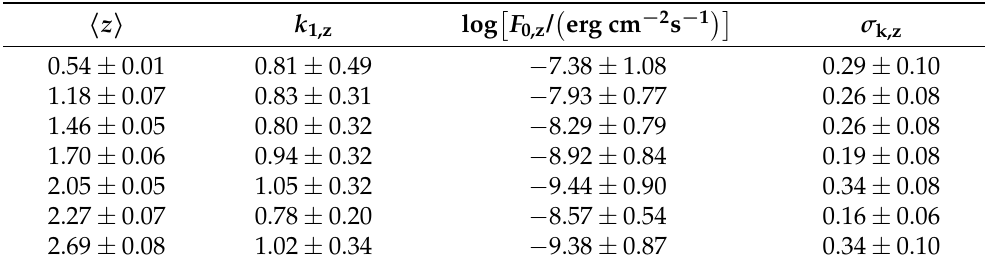
Table 8. Best-fit parameters of the seven sub-samples at average redshift (cid:104) z (cid:105) : the slope q 1,z , the nor- malization log F 0,z , and the extrascatter σ q,z are shown.